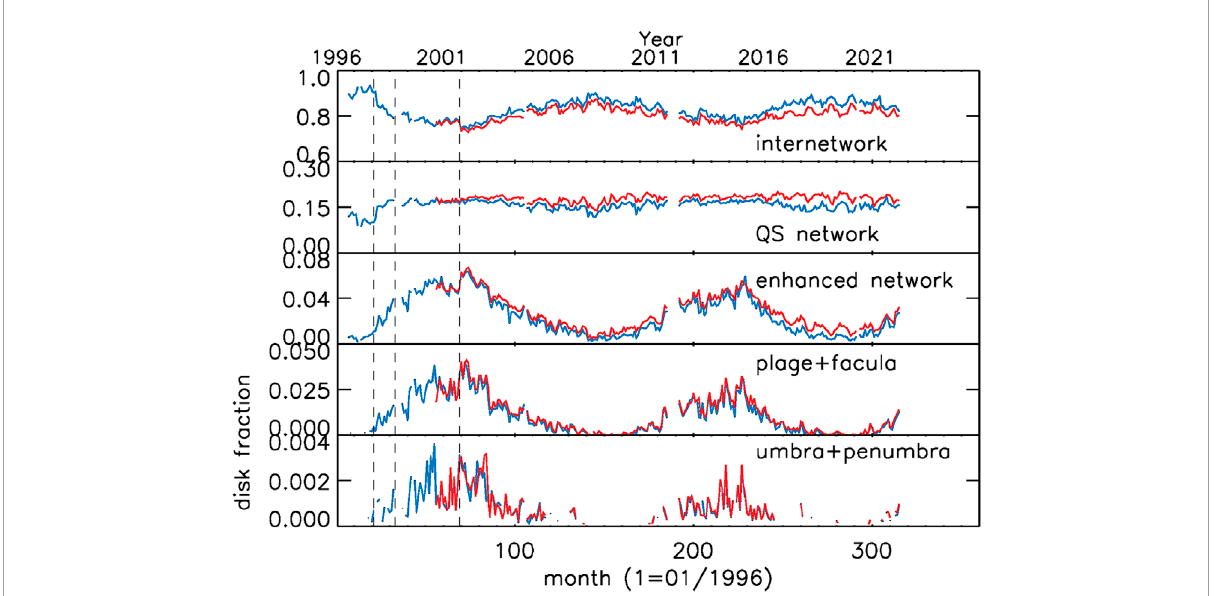
FIGURE 13 Evolution of fractional areas of the seven classes of solar features identified on the Rome/PSPT observations acquired from 1996 to 2022. Lines show monthly median values; red and blue colors are used to show results from single exposure and sum of 25 exposure observations,